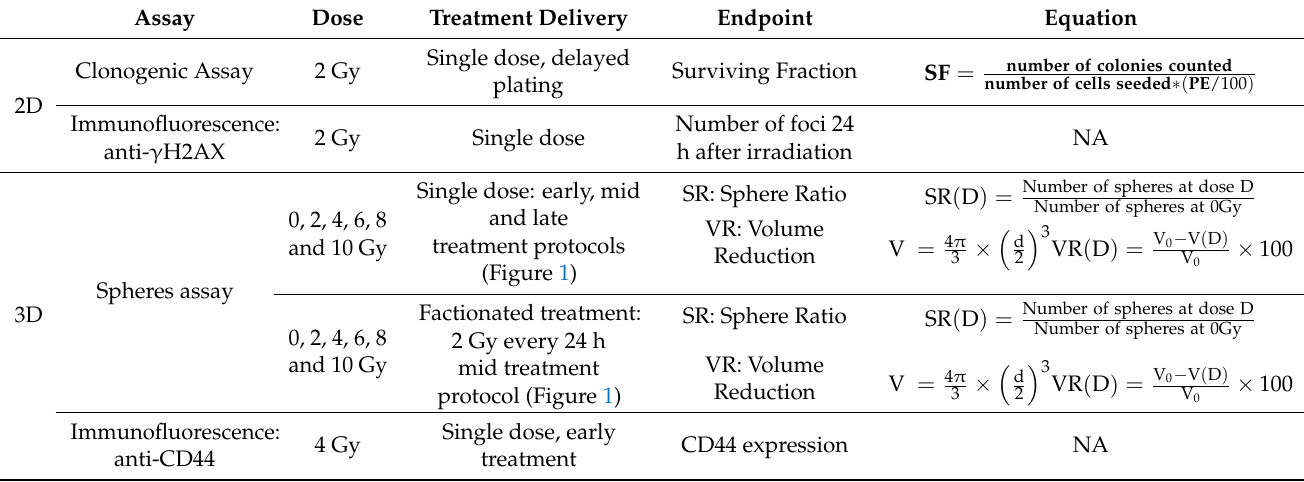
Table 2. Summary of all the experiments performed in this